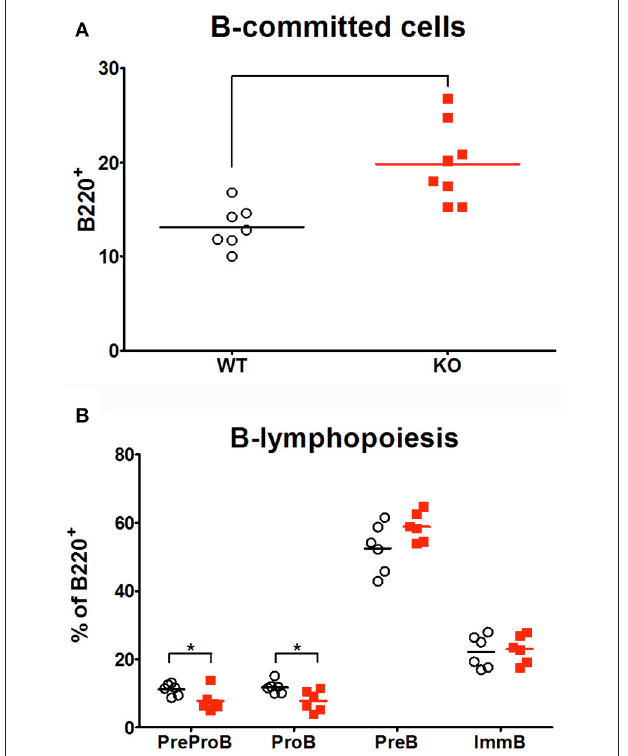
FIGURE 4 | B lymphopoiesis. The percentage of B-committed cells amongst living cells (A) and the proportion amongst B220 + population of the four developmental stages of B cell development (B) were analyzed by flow cytometry in bone marrow of WT ( ◦ ), KO ( ) mice. Data (mean) are representative of 3 independent experiments. Unpaired t -test was used for statistical analysis. N = 7–8 per group. * p < 0.05.